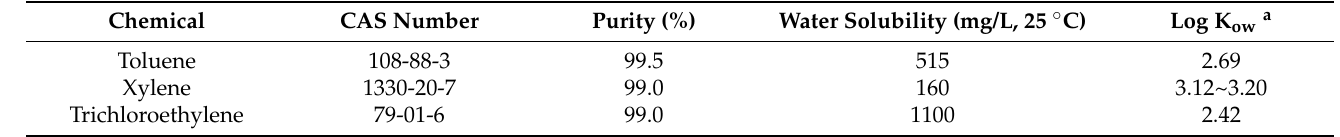
Table 1. Chemical information of volatile PAs used in this